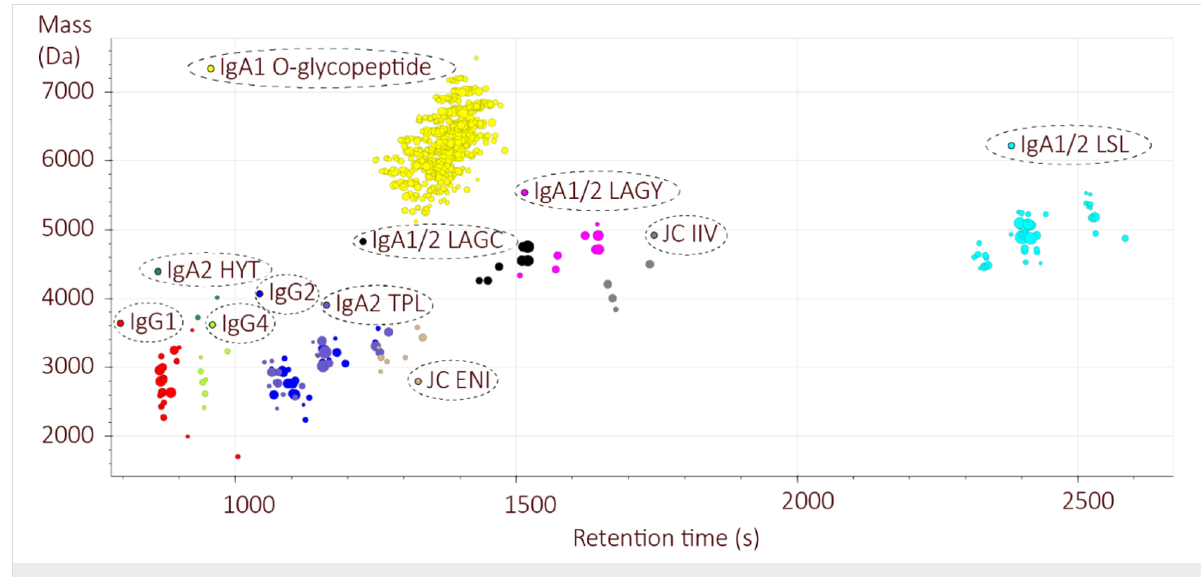
and is discussed in the section on automated MS1- and RT-based glycopeptide identification by Glycopeptide-